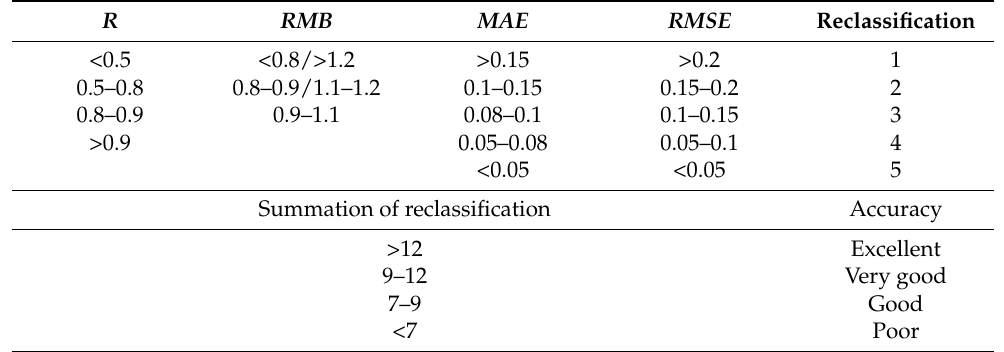
Table 3. The division of evaluation indicators and accuracy, including R , RMB , MAE , RMSE , and Matching